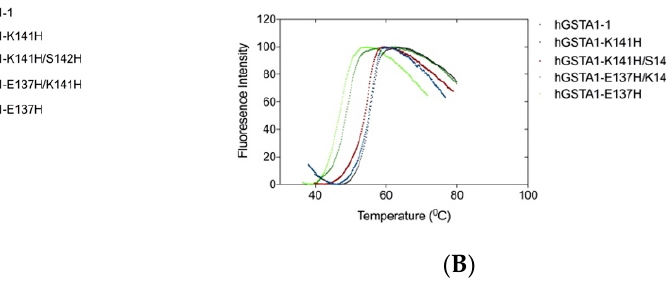
Figure 5. ( A ) Enzyme residual activity curves for hGSTA1-1 (black line), hGSTA1-K141H (grey line), hGSTA1-K141H/S142H (red line), hGSTA1-E137H/K141H (green line), and hGSTA1-E137H (orange line). The residual activities were measured after heat treatment at various temperatures (°C) for 5 min. Values presented are given as a mean of triplicates ± SE. ( B ) Melting curve measurements by DSF (scan rate of 1 °C/min) for hGSTA1-1(black), hGSTA1-K141H (blue), hGSTA1-K141H/S142H (red), hGSTA1-E137H/K141H (green), and hGSTA1-E137H (light green). Table 3. Half-inactivation temperature (T 1/2 ) of hGSTA1-1 and its mutants.